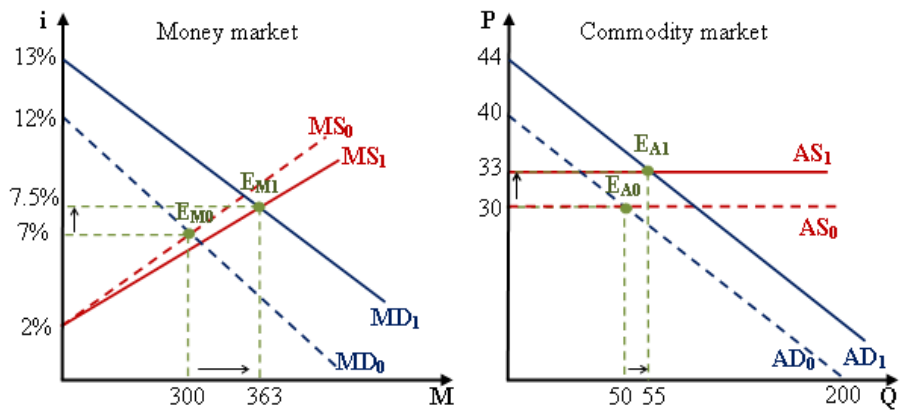
Figure 12. Case of the steady-state equilibrium economy .